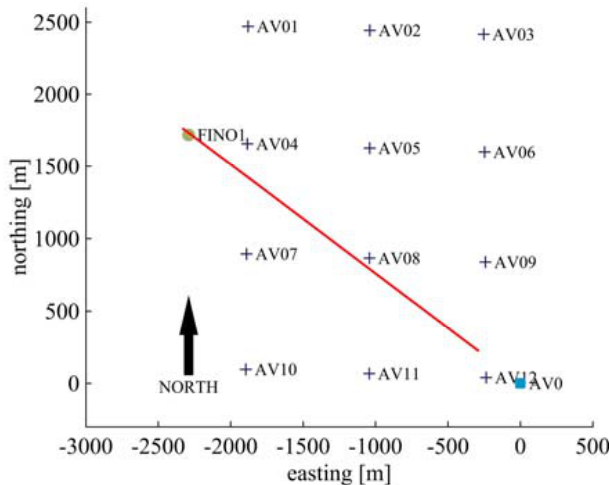
Figure 6. Layout of the wind farm “alpha ventus” with measurement geometry of staring mode LiDAR with an azimuthal orientation of 306.47° and an elevation of 0.2° (red). Crosses represent wind turbines, the circle the platform FINO1 and the square the substation AV0. The measurement positions are indicated by the red line.